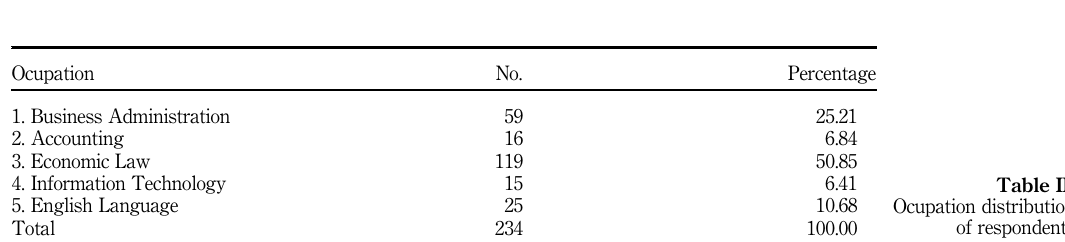
Table II. Ocupation